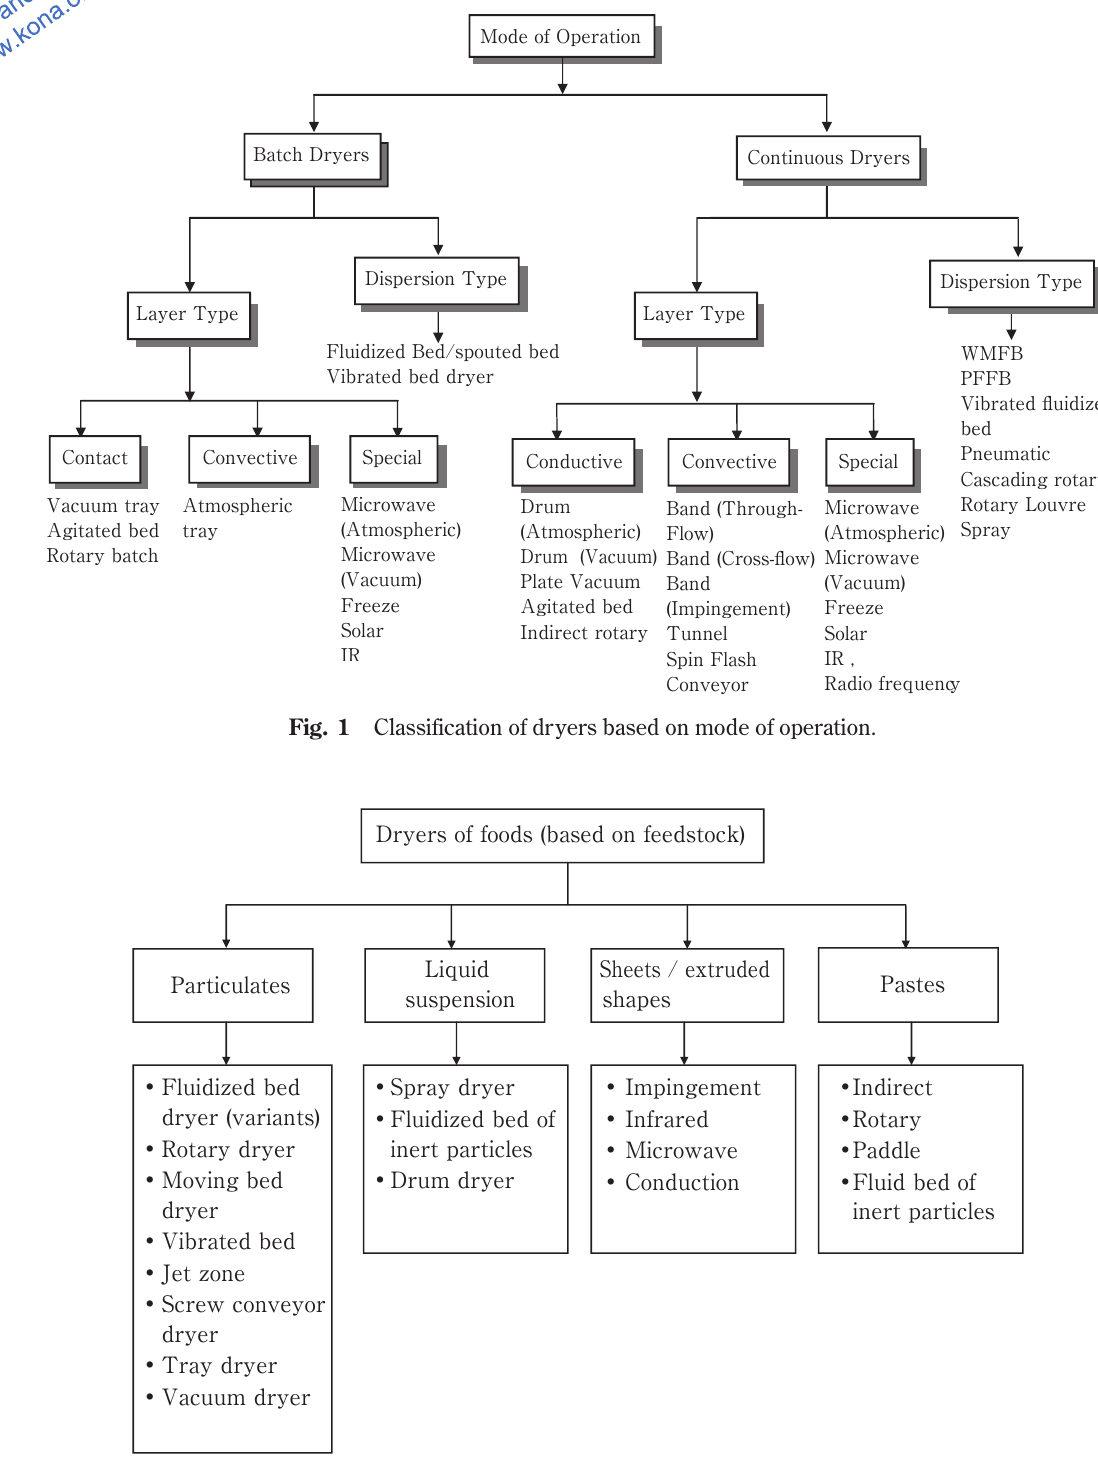
Fig. 2 Classification of dryers for food